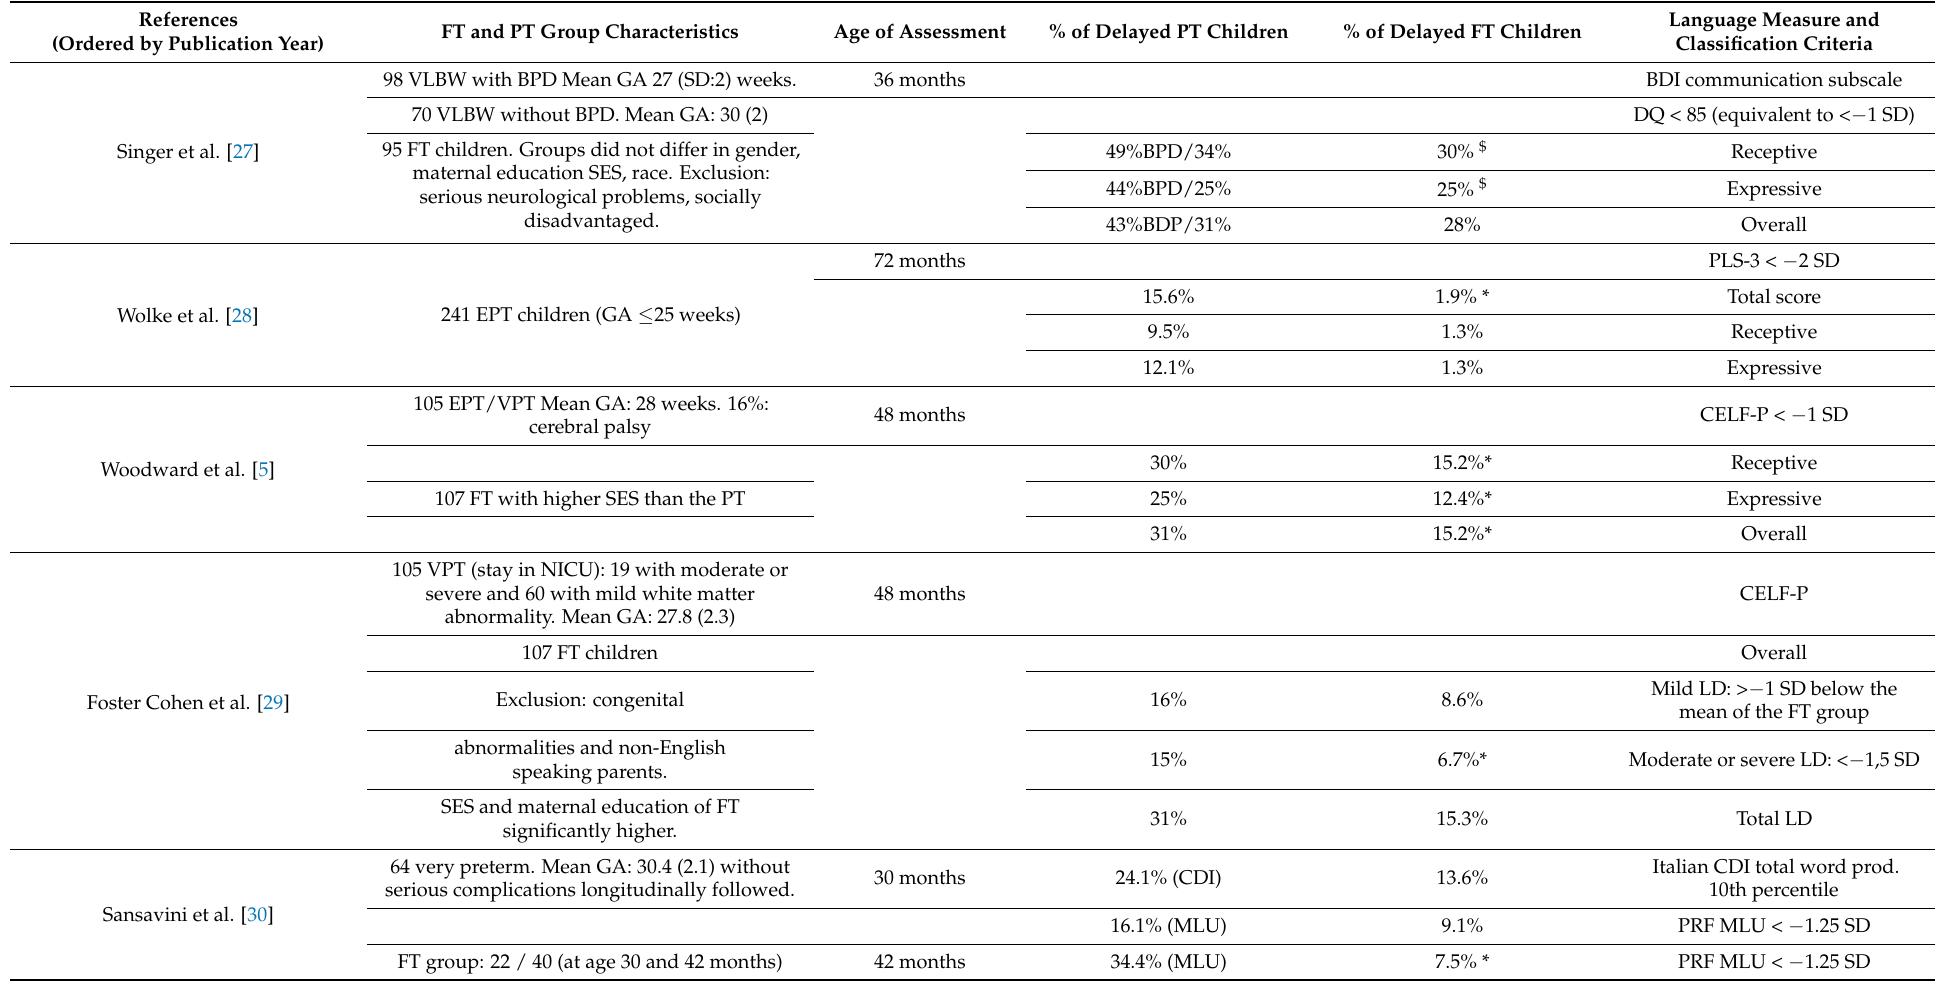
Table 1. Summary of the investigations which compared the prevalence of LD in preterm (PT) and full-term (FT)